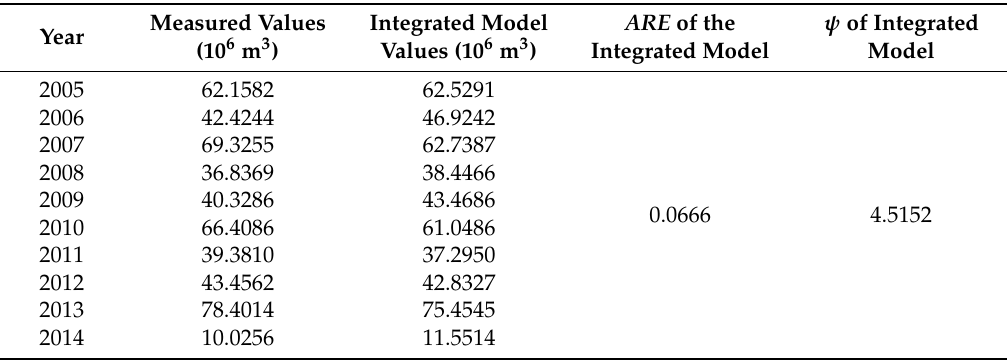
Table 2. Calculation results under the integrated